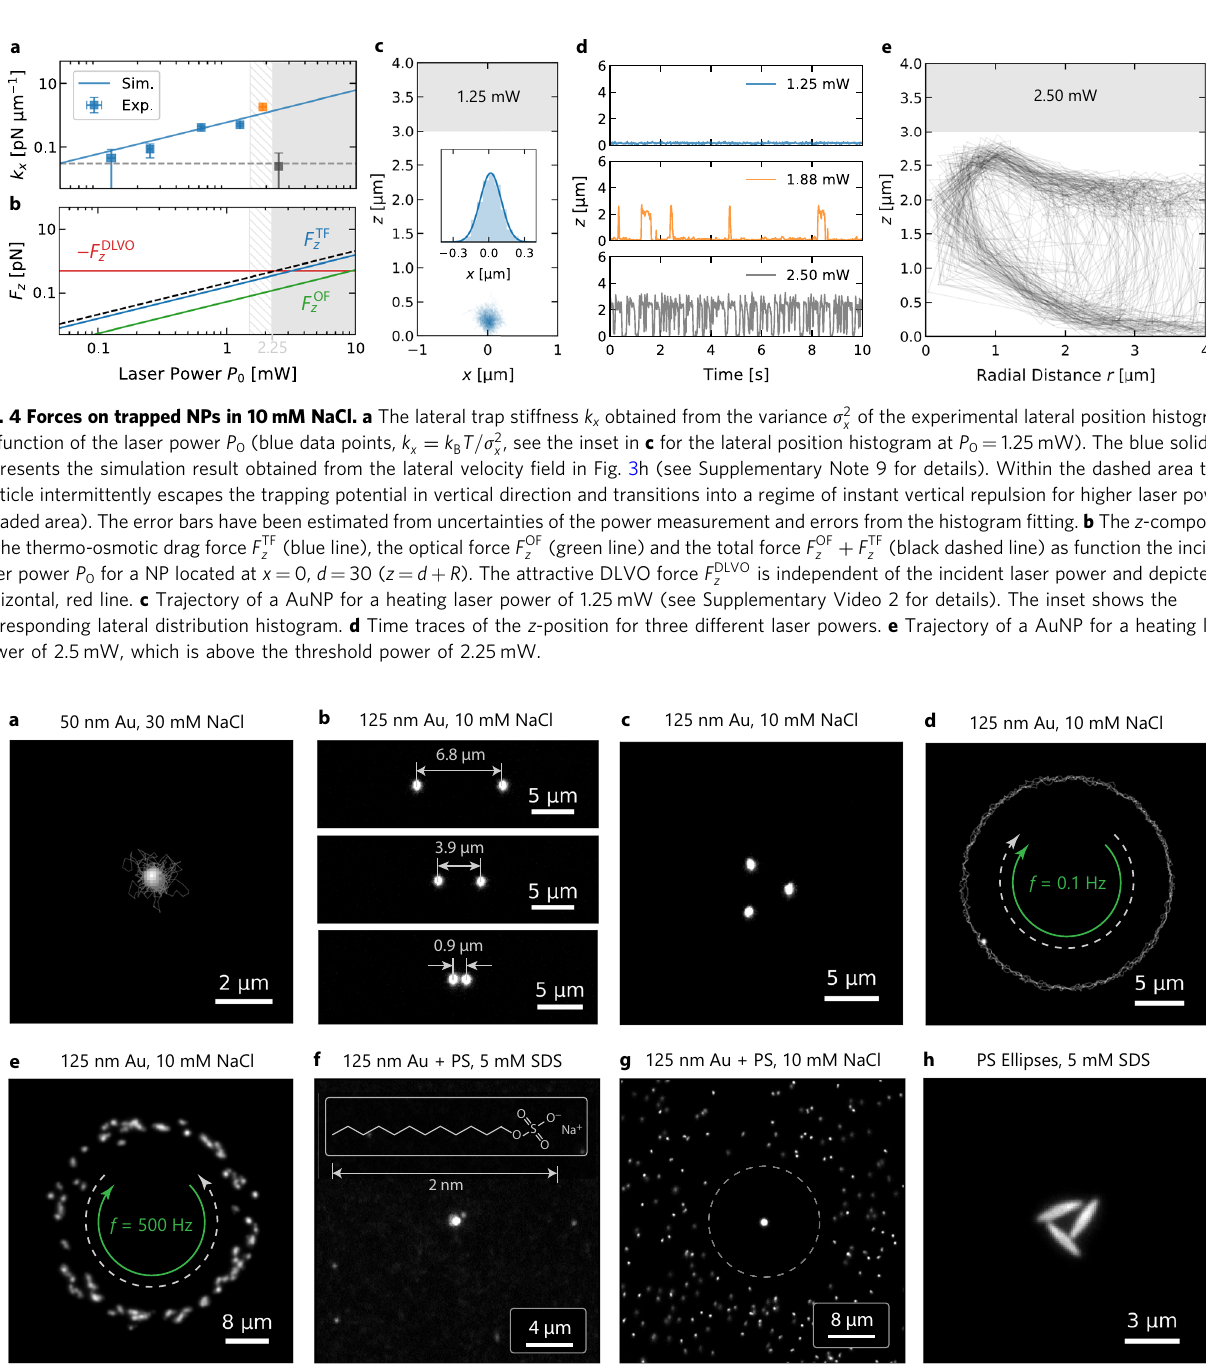
Fig. 5 Manipulation of NPs over a Au fi lm in NaCl and SDS solution. a AuNP with 50 nm radius trapped at a NaCl concentration of 30 mM (Supplementary Video 5). b Manipulation of two AuNPs by a multiplexed laser beam (Supplementary Video 6). c Control of three AuNPs (Supplementary Video 7). d Actuation of a single AuNP on a circular trajectory by a steerable laser beam (Supplementary Video 8). The green and white, dashed arrows denote the moving direction of the laser focus and the particle, respectively. e Generation of thermo-viscous fl ows by rotating the laser focus on a circle with a rotation frequency of f = 500 Hz at high laser powers (Supplementary Video 9). Note that laser movement (green arrow) and the thermo-viscous fl ow (white, dashed arrow) and have opposite directions. f Attraction of a AuNP and PS NPs in 5 mM SDS due to depletion (Supplementary Video 10). g An AuNP (125 nm radius) trapped in an ensemble of polystyrene (PS) NPs of the same size at 10 mM NaCl (Supplementary Video 11), where the PS particles are repelled due to thermophoresis. h Attraction of PS ellipsoids (2.39 μ m major-axis length, 0.34 μ m minor-axis length) in 5 mM SDS (Supplementary Video